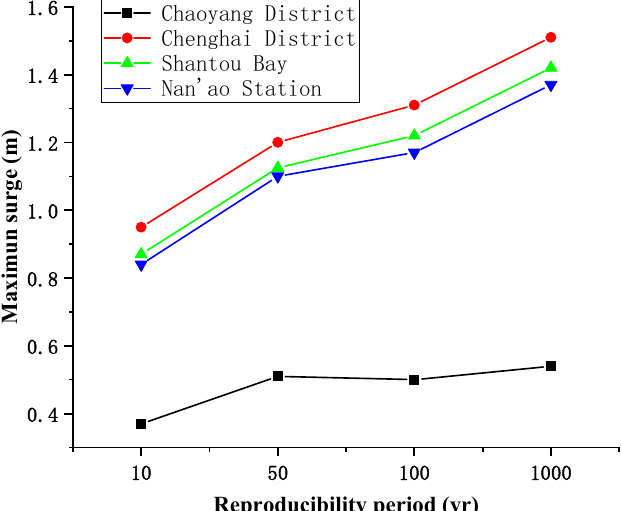
Figure 6. The maximum water increase in different return periods is obtained from the four stations of Nan‘ao Station, Chaoyang District, Chenghai District, and Shantou Bay (The maximum water increase is shows an increasing trend with the increase of return period years).